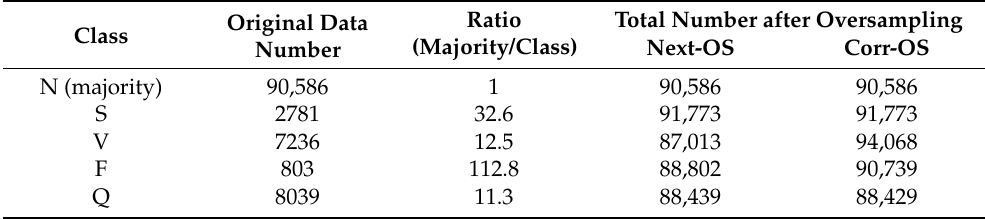
Table 3. Data numbers in the dataset used in the